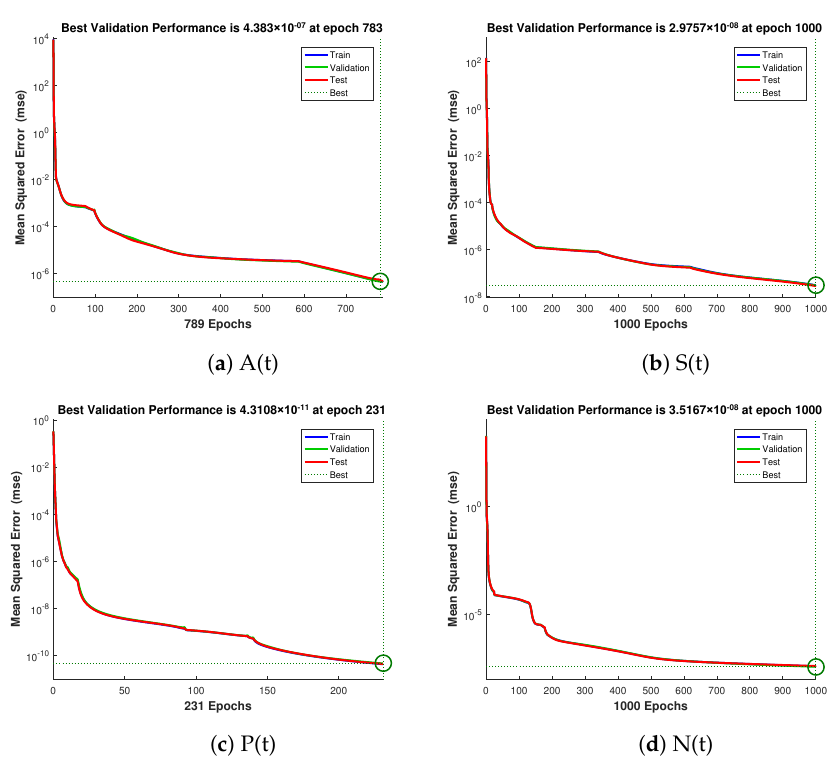
Figure 6. Mean square error of NNs-LMT for crop production, insects density, insecticides concentra- tion, and external effort of case